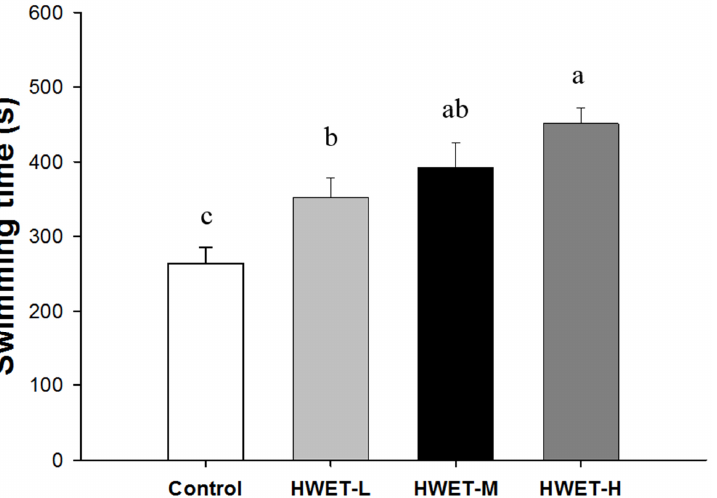
Figure 1. Effects of HWET treatment on swimming time in ICR mice. Mice were treated with vehicle (control), 800 mg/kg (HWET-L), 1600 mg/kg (HWET-M), or 4000 mg/kg (HWET-H) of HWET once per day for 7 days, and conducted the swimming test 1 h after the last administration. Values are expressed as the mean ± SEM. Different letters indicate statistical difference, p < 0.05.